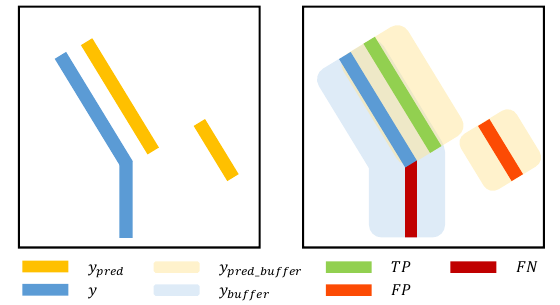
Figure 2. Calculating evaluation metrics for line features. We skeletonize both predictions and ground truth and calculate the metrics in a buffered distance. Predicted centerline pixels y pred are regarded as true positives TP if they lie in a buffer of ground truth y and false positives FP otherwise. Ground-truth centerline pixels are regarded as false negatives FN if they don’t lie in a buffer of the predicted centerline y pred